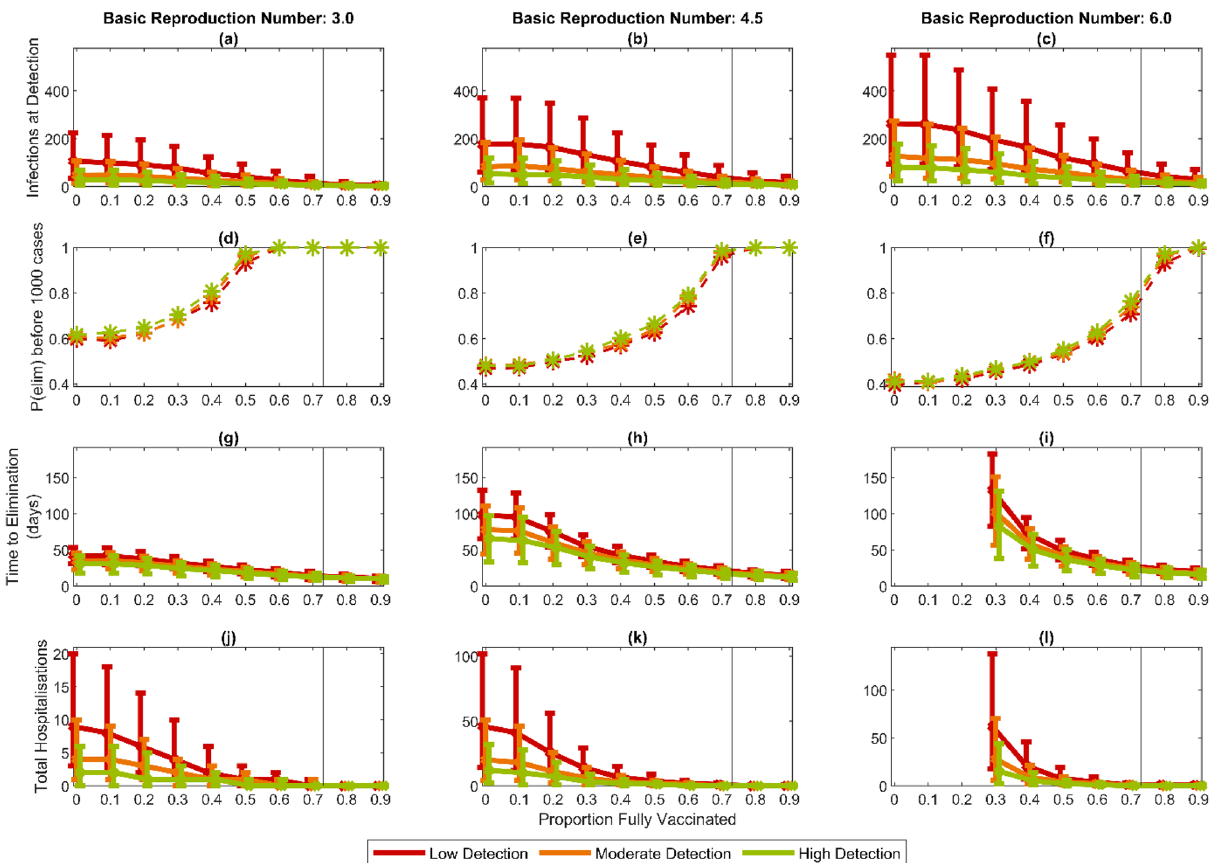
Figure 3. Detection and control of small outbreaks as vaccine coverage increases: ( a – c ) number of infections when a community outbreak is first detected; ( d – f ) probability an outbreak is eliminated before reaching 1000 cases without population-level interventions; ( g – i ) time from detection to elimination with population-level interventions; ( j – l ) total number of hospitalisations before outbreak is eliminated. Results are shown for three values of R 0 and three values of the probability of testing for symptomatic individuals in the period before pre = 5% (red), p pre = 10% (amber) and p pre = 15% (green). In ( d – f ), case the outbreak is detected: p detect detect detect isolation and contact tracing are introduced after outbreak detection giving 43% reduction in R eff ; in ( g – l ), population-level restrictions are also introduced after outbreak detection giving a total 81% reduction in R eff ; note that in ( i ) and ( l ) when R 0 = 6 , an 81% reduction in R eff is insufficient to achieve elimination when vaccine coverage is less than around 20%. The black vertical line represents the point in the vaccine roll-out at which vaccination of under 15-year-olds begins. Points are the median and error bars represent the interquartile range of 10,000 independently initialised realisations of the stochastic